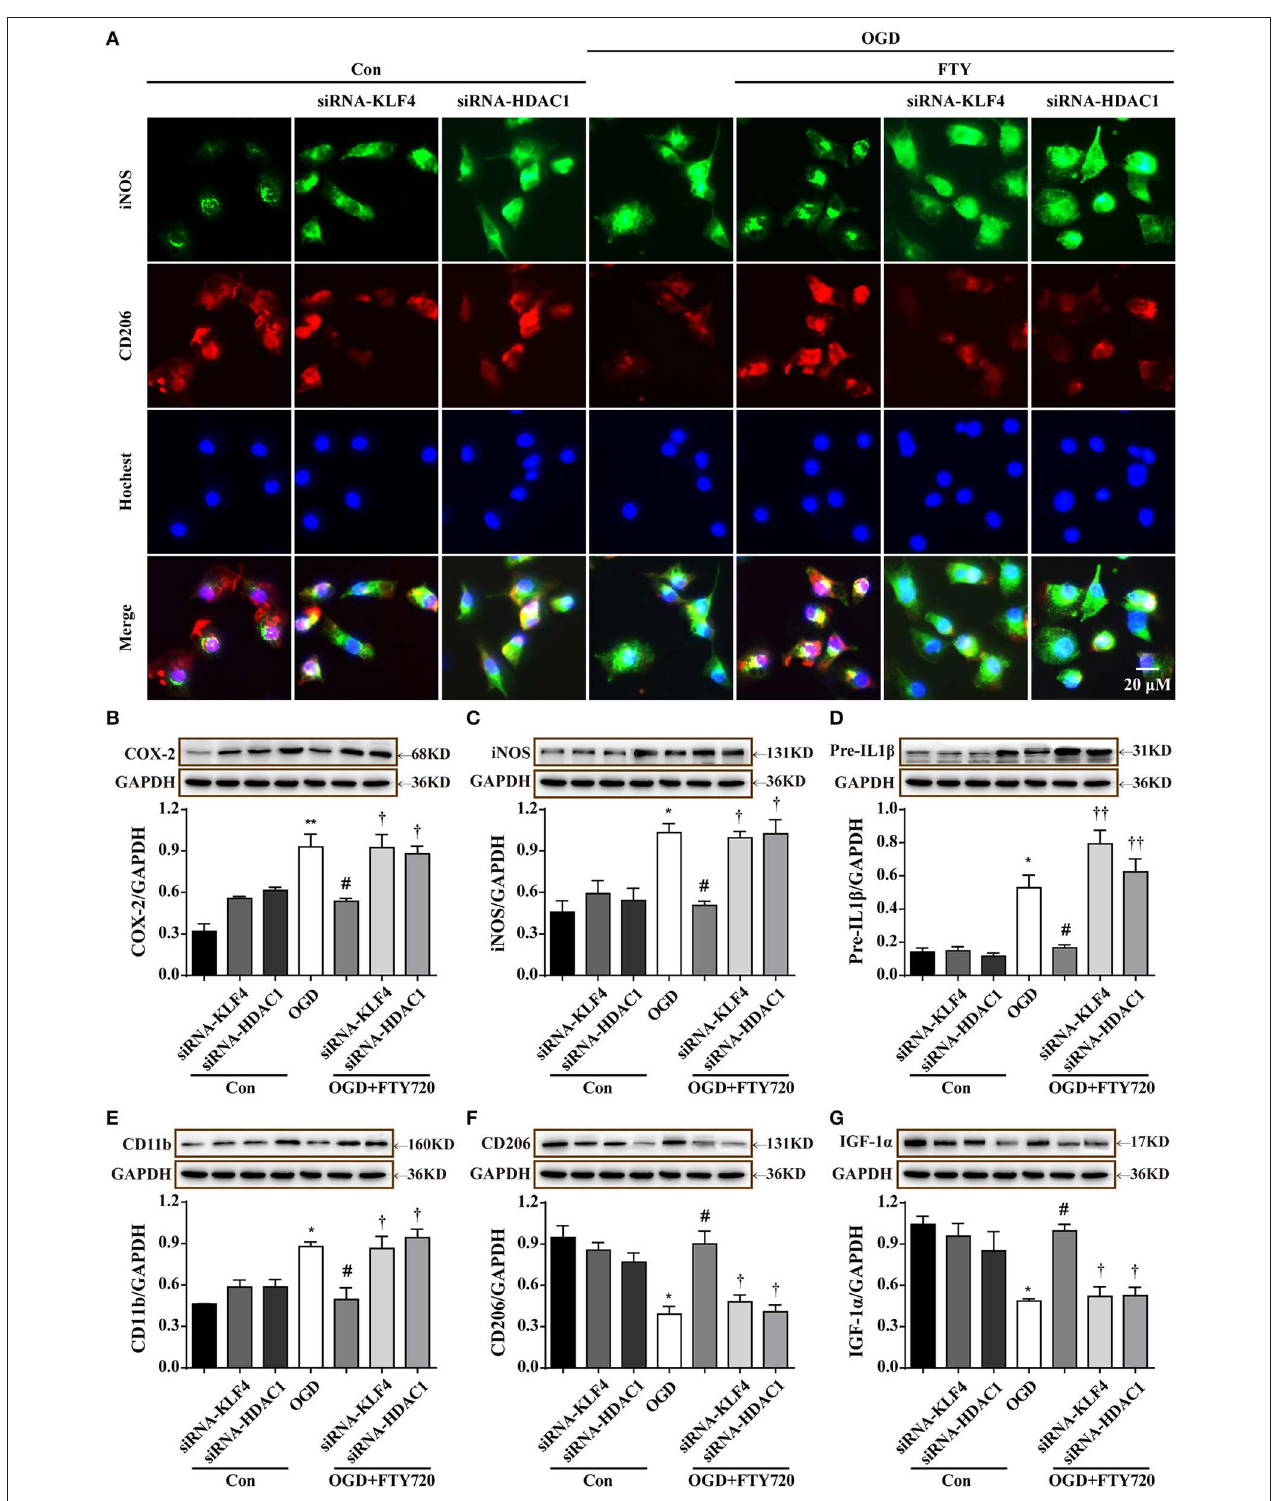
FIGURE 6 | Suppressing KLF4 deacetylation is necessary for FTY720-mediated the primary microglial M1-to-M2 polarization. (A) Knockdown LKB1 or HDAC1 reversed FTY720-induced the changes in the protein expressions of M1 markers (iNOS, green) and M2 markers (CD206, red) by Immunofluorescent staining. Scale bar = 20 µ m. (B–G) Representative Western blots was used to quantify the expression of M1 markers (CD11b, COX-2, iNOS, and IL-1 β ) and M2 markers (CD206